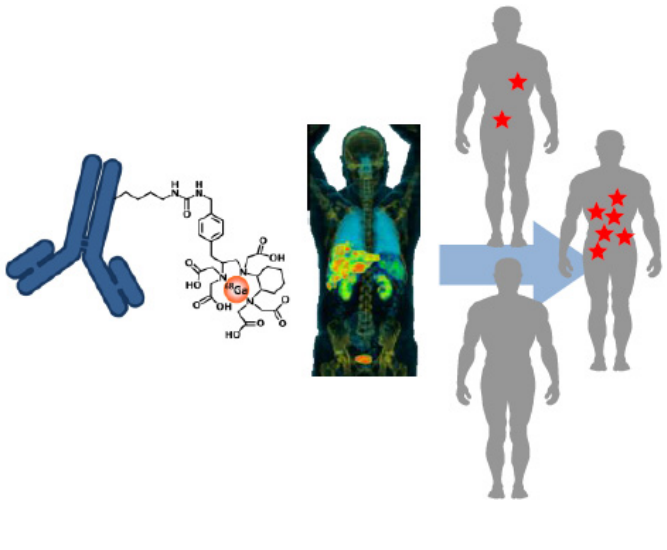
Figure 1. Illustration showing the use of a radiolabeled antibody in personalized medicine. The introduced radiopharmaceutical allows for an indication of which patients will respond better to therapy, due to the heterogeneity of tumors, thus suggesting radiolabeled antibodies have potential use in stratified